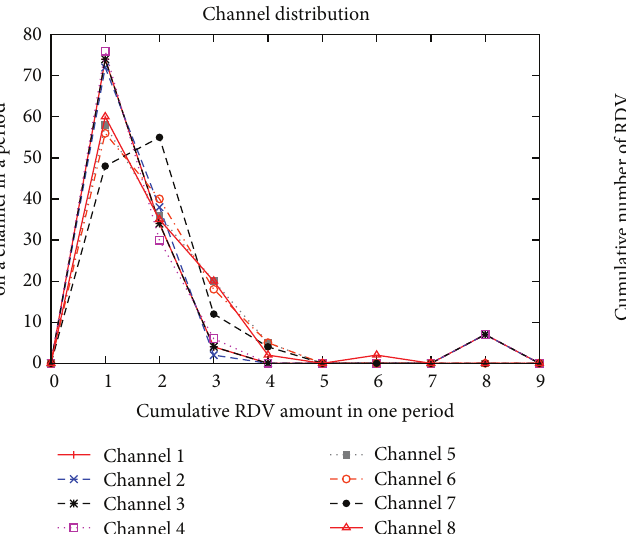
Figure 14: MtQS-DSrdv: 8 channels (120 slots).